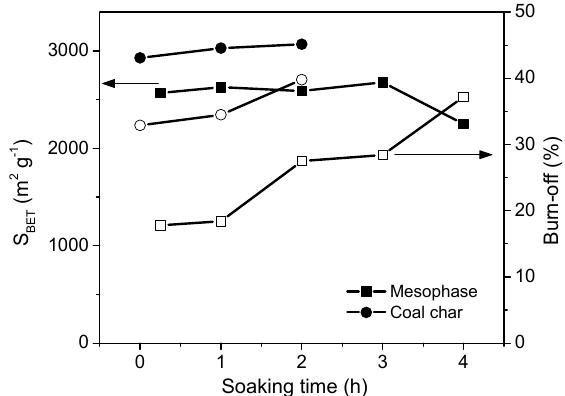
Figure 11. Effect of soaking time on the BET surface area (closed symbols) and burn-off (opened symbols) of coal-tar pitch mesophase and bituminous coal-derived char activated by KOH at a precursor/KOH ratio of 1:3 at 800 °C.